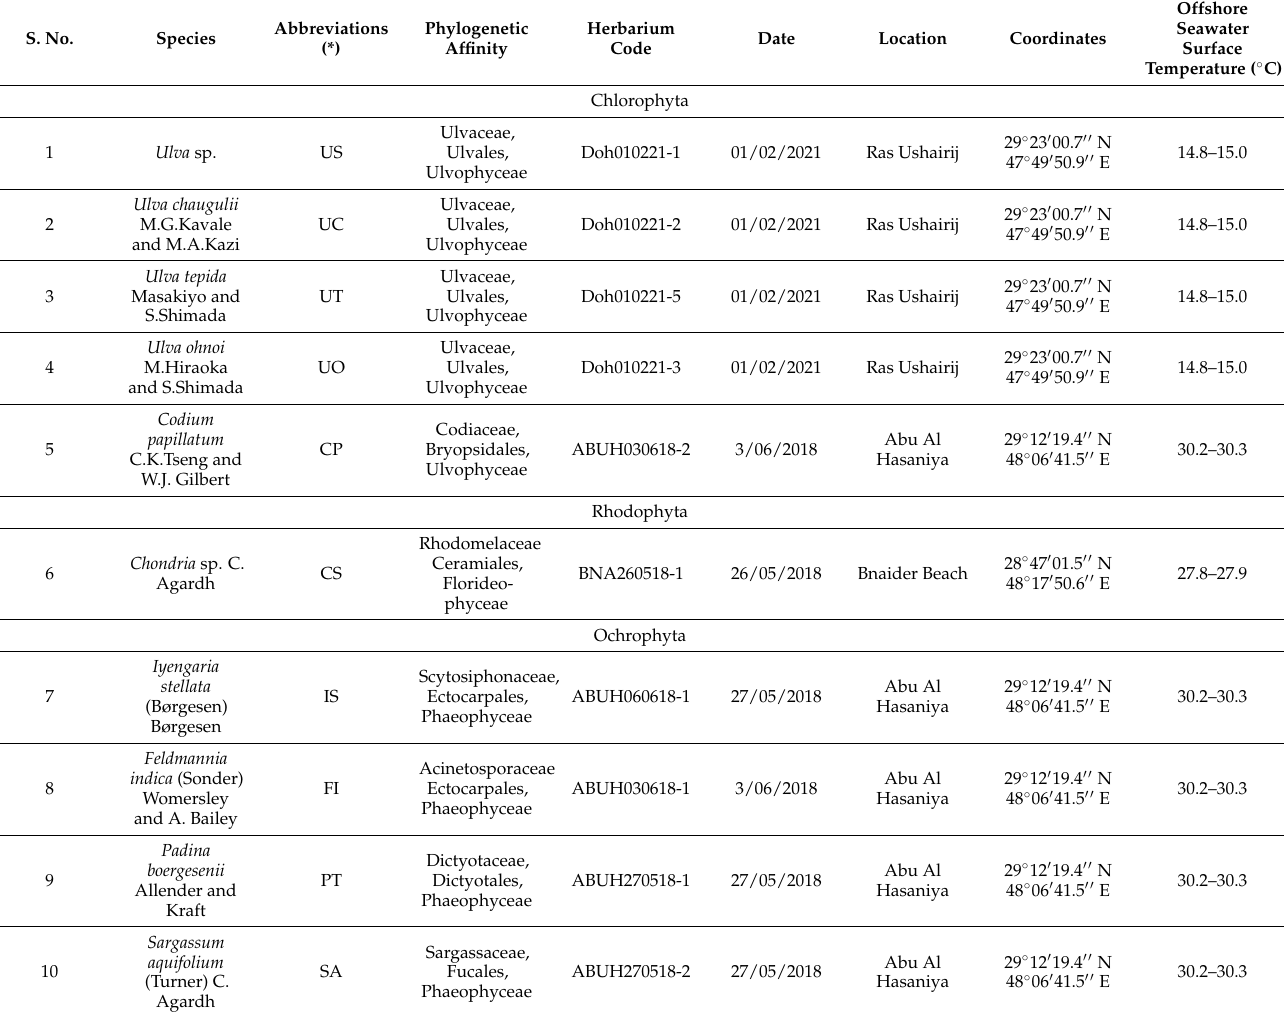
Table 1. Locations of macroalgal sampling sites along the Kuwait